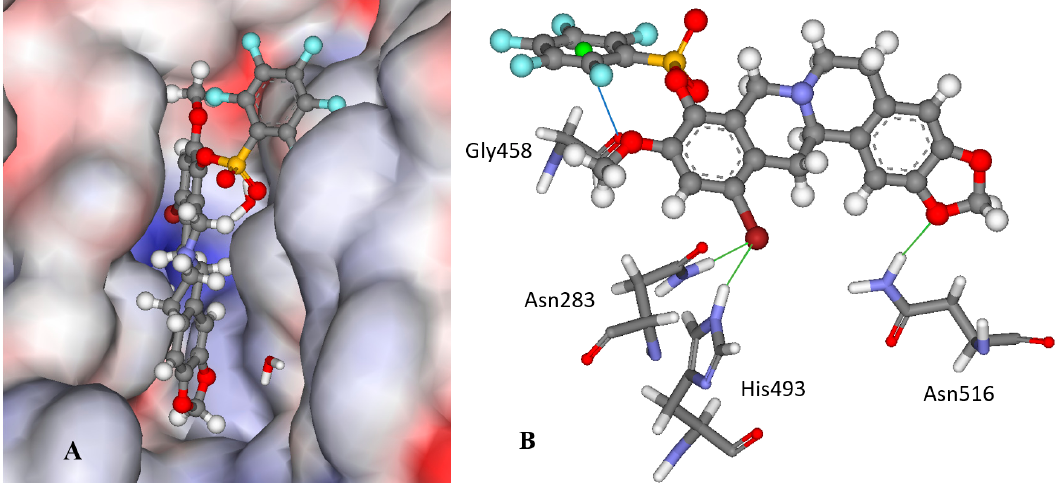
Figure 3. The docked configuration of 12f in the binding site of Tdp1 as predicted by the ChemPLP scoring function. ( A ) The protein surface is rendered; blue depicts a hydrophilic region with a partial positive charge on the surface; red depicts hydrophobic region with a partial negative charge and grey shows neutral areas. The ligand occupies the catalytic pocket blocking access to it. ( B ) H-bonds are shown as green lines between 12f and the amino acids Asn283, His493 and Asn516 side chains. A potential lone pair- π stacking interaction is shown as a blue line between the carboxylic backbone group in Gly458 and the centroid (green ball) of the fluorinated phenyl group (3.5